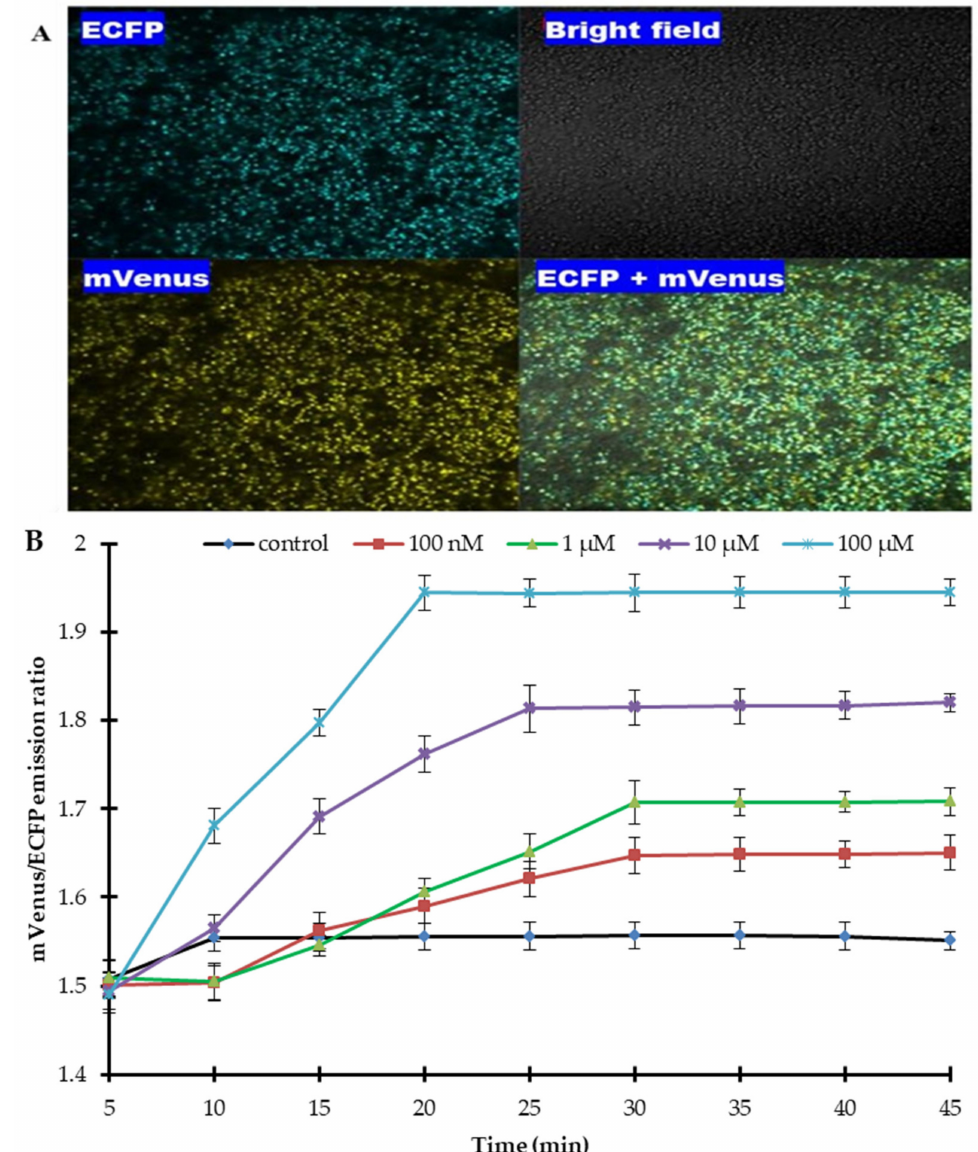
Figure 7. Real-time monitoring of sulfate levels in E. coli using the FLIP-SP nanosensor. ( A ) Confocal imaging of E. coli BL21-CodonPlus (DE3) cells expressing the FLIP-SP. ECFP, mVenus, and ECFP + mVenus (merged) indicate the specific excitation and emission wavelength of the fluorophores. ( B ) Measurement of the sulfate uptake for 45 min. in E. coli as the Venus / ECFP emission ratio changes in response to di ff erent concentrations of sulfate. Values are the mean of three independent replicates. Vertical bars indicate standard